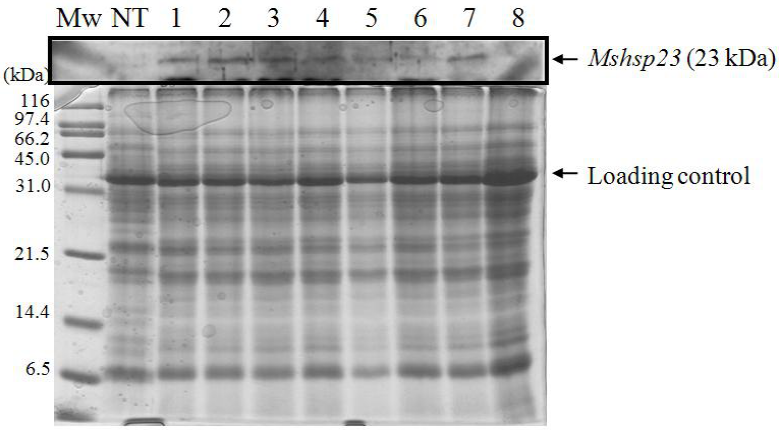
Figure 4. SDS PAGE (top panel) and Western blot analysis of MsHsp23 in transgenic tall fescue leaf protein (bottom panel). Twenty-five micrograms of protein was loaded in each lane, separated on 12.5% SDS-PAGE, and visualized by CBB staining (upper panel). Mw, marker; NT, non-transgenic control plant; 1-8, transgenic lines.